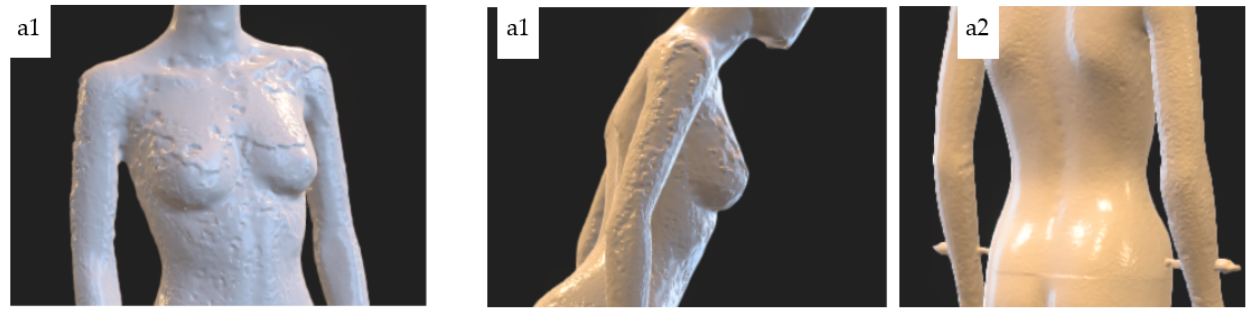
Figure 11. Selected characteristic fragments of 3D models for variants a1 and a2.